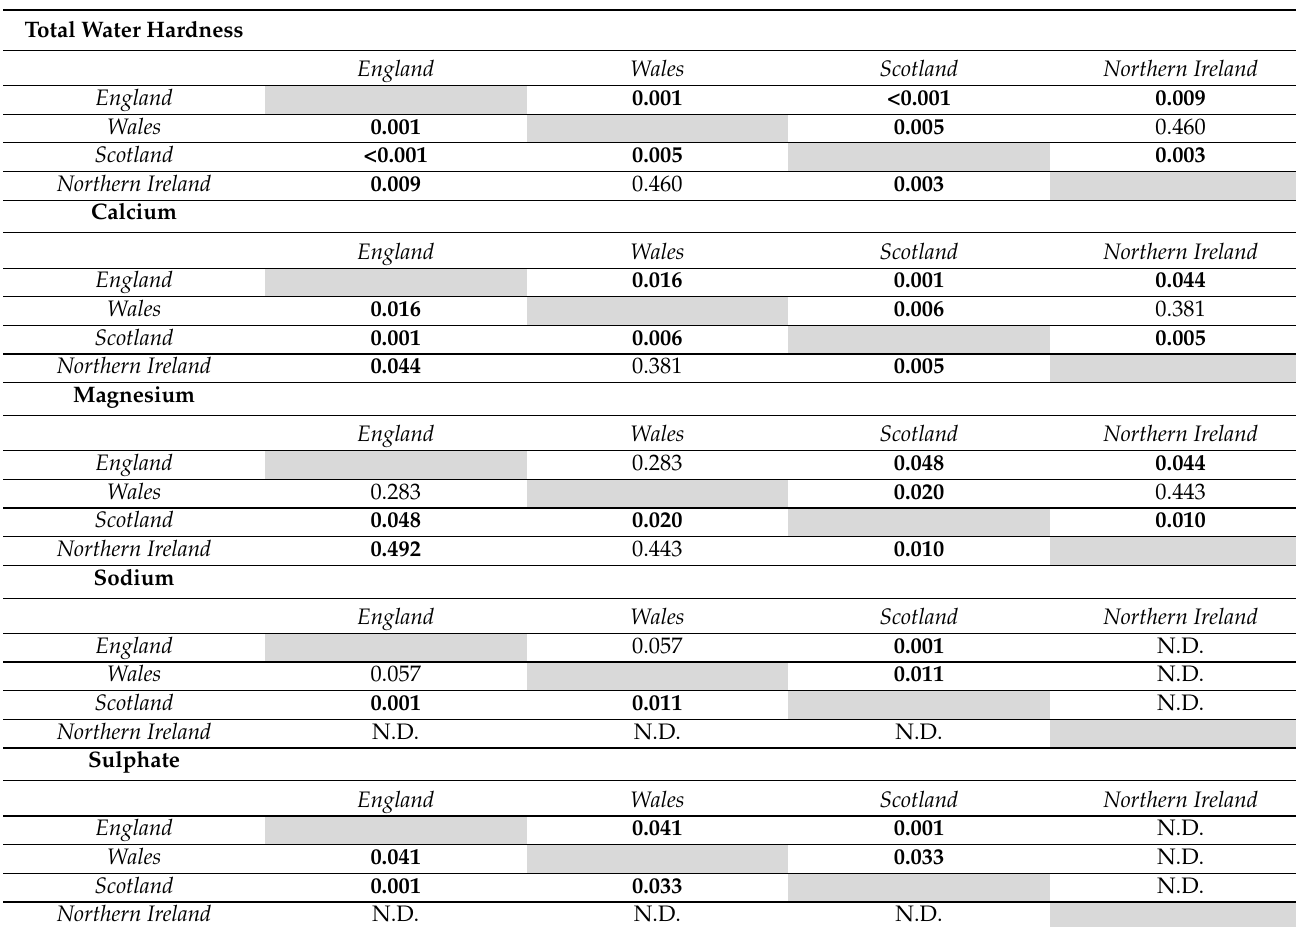
Table 2. Pairwise t-test significance values for differences in mean water variables by country in the United